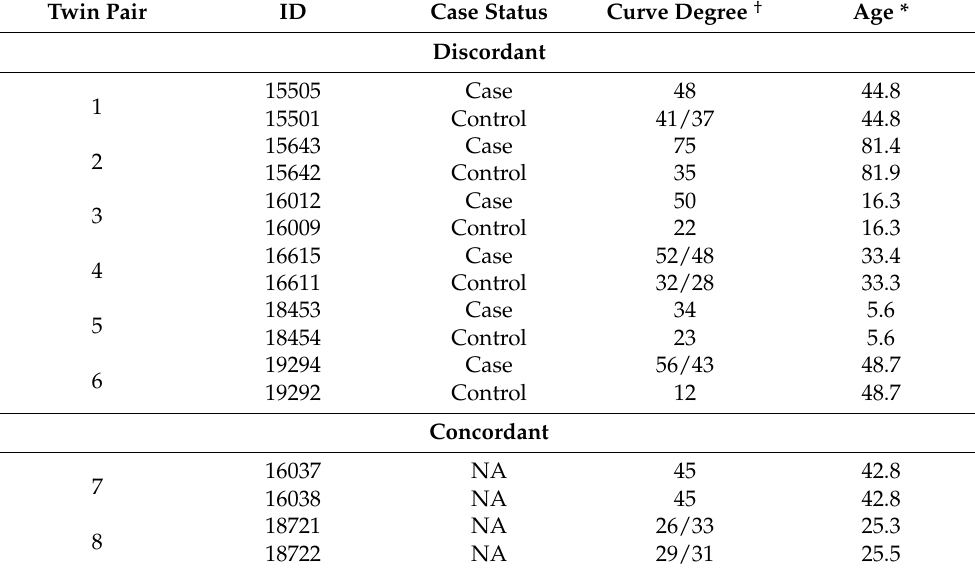
Table 1. Demographics and Clinical